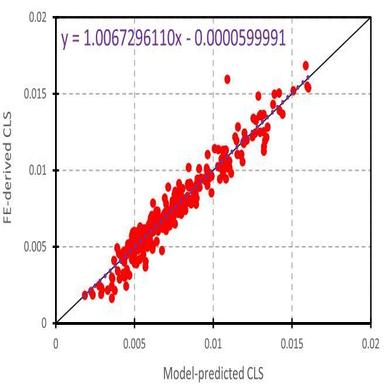
RHT model prediction vs. FEA.